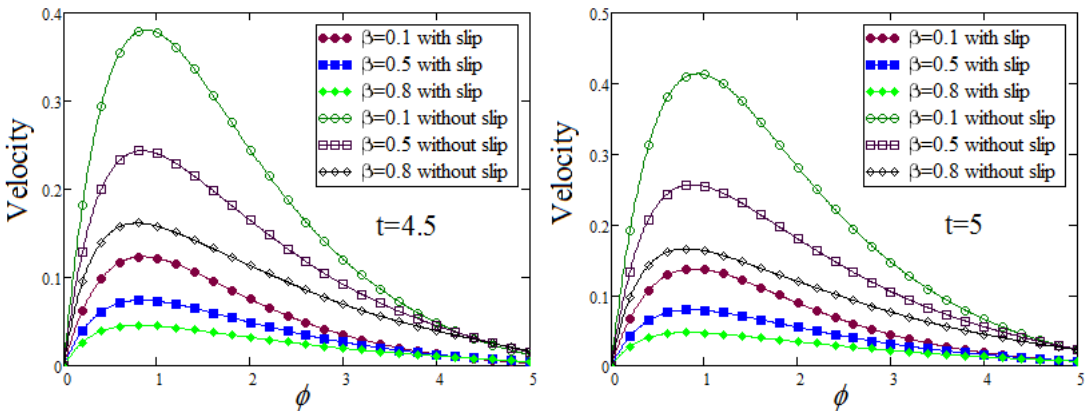
Figure 10. Graphical representations of velocity profile in the presence of slip and no slip conditions by taking the dissimilar values of α at two different levels of time, when Gr = 5, Gm = 3.5, ℘ = 0.4, Pr = 12, ω = 0.5, Sc = 9, γ = 0.3, and β = 0.5.